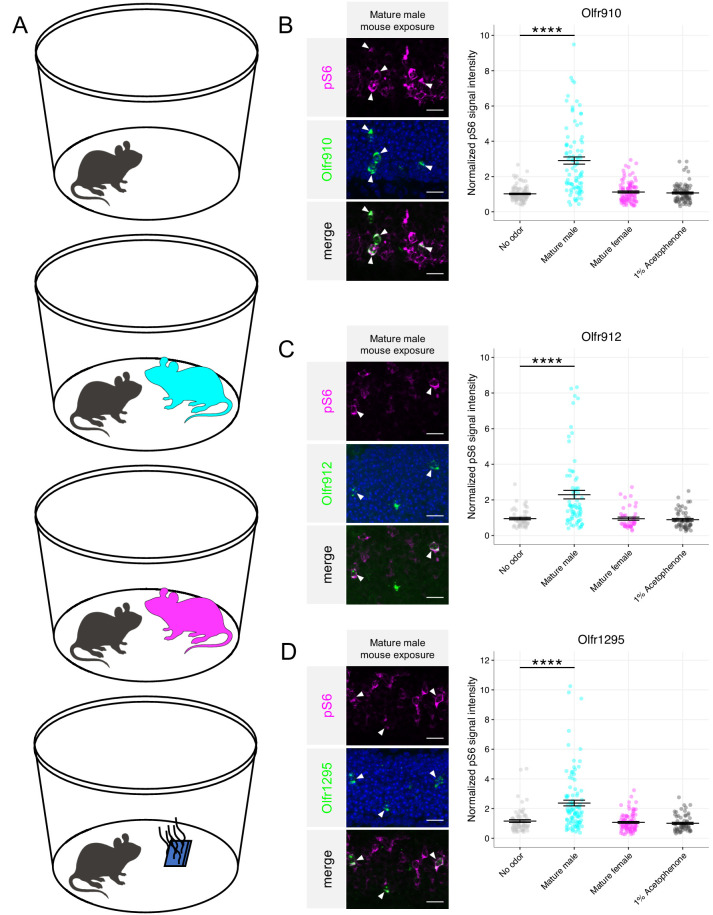
Sexually dimorphic ORs are activated by mature male mouse odor.(A) Schematic of exposure experiment. A juvenile mouse (black) was exposed to (in descending order) a clean environment, mature male mice, mature female mice, or 1% (v/v) acetophenone for 1 hr in a sealed container. (B) Left: representative in situ mRNA hybridization and pS6 immunostaining showing co-localization events, as indicated by arrowheads, between OSNs expressing Olfr910 and pS6 signal induction following exposure of a juvenile mouse to adult male mice. Scale bars indicate 20 μm. Right: summary data showing the mean and SEM of pS6 induction in OSNs expressing Olfr910 following exposure of a juvenile mouse to multiple stimuli. One-way ANOVA with Dunnett’s multiple comparisons test correction reveals that only exposure to mature male mice leads to significant (****p < 0.0001) pS6 induction within OSNs expressing Olfr910. Data are from n = 3 juvenile mice. (C) Left: representative in situ mRNA hybridization and pS6 immunostaining showing co-localization events between OSNs expressing Olfr912 and pS6 signal induction following exposure of a juvenile mouse to adult male mice. Right: summary data showing the mean and SEM of pS6 induction in OSNs expressing Olfr912 following exposure of a juvenile mouse to multiple stimuli (****p < 0.0001). (D) Left: representative in situ mRNA hybridization and pS6 immunostaining showing co-localization events between OSNs expressing Olfr1295 and pS6 signal induction following exposure of a juvenile mouse to adult male mice. Right: summary data showing the mean and SEM of pS6 induction in OSNs expressing Olfr1295 following exposure of a juvenile mouse to multiple stimuli (****p < 0.0001).Figure 3—source data 1.Summary statistics for Figure 3.